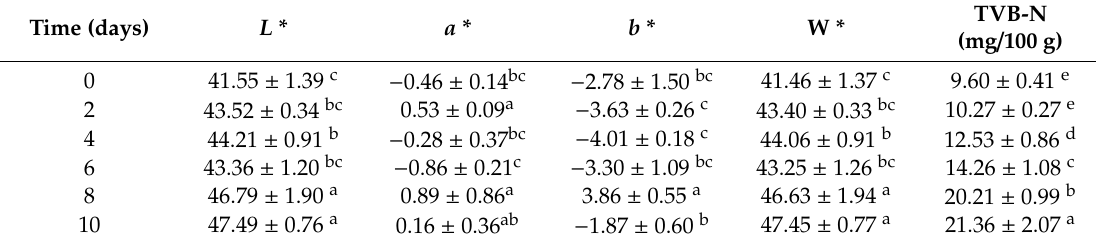
Table 1. Changes in the color and TVB-N of hybrid grouper fillets during storage at 4 ◦